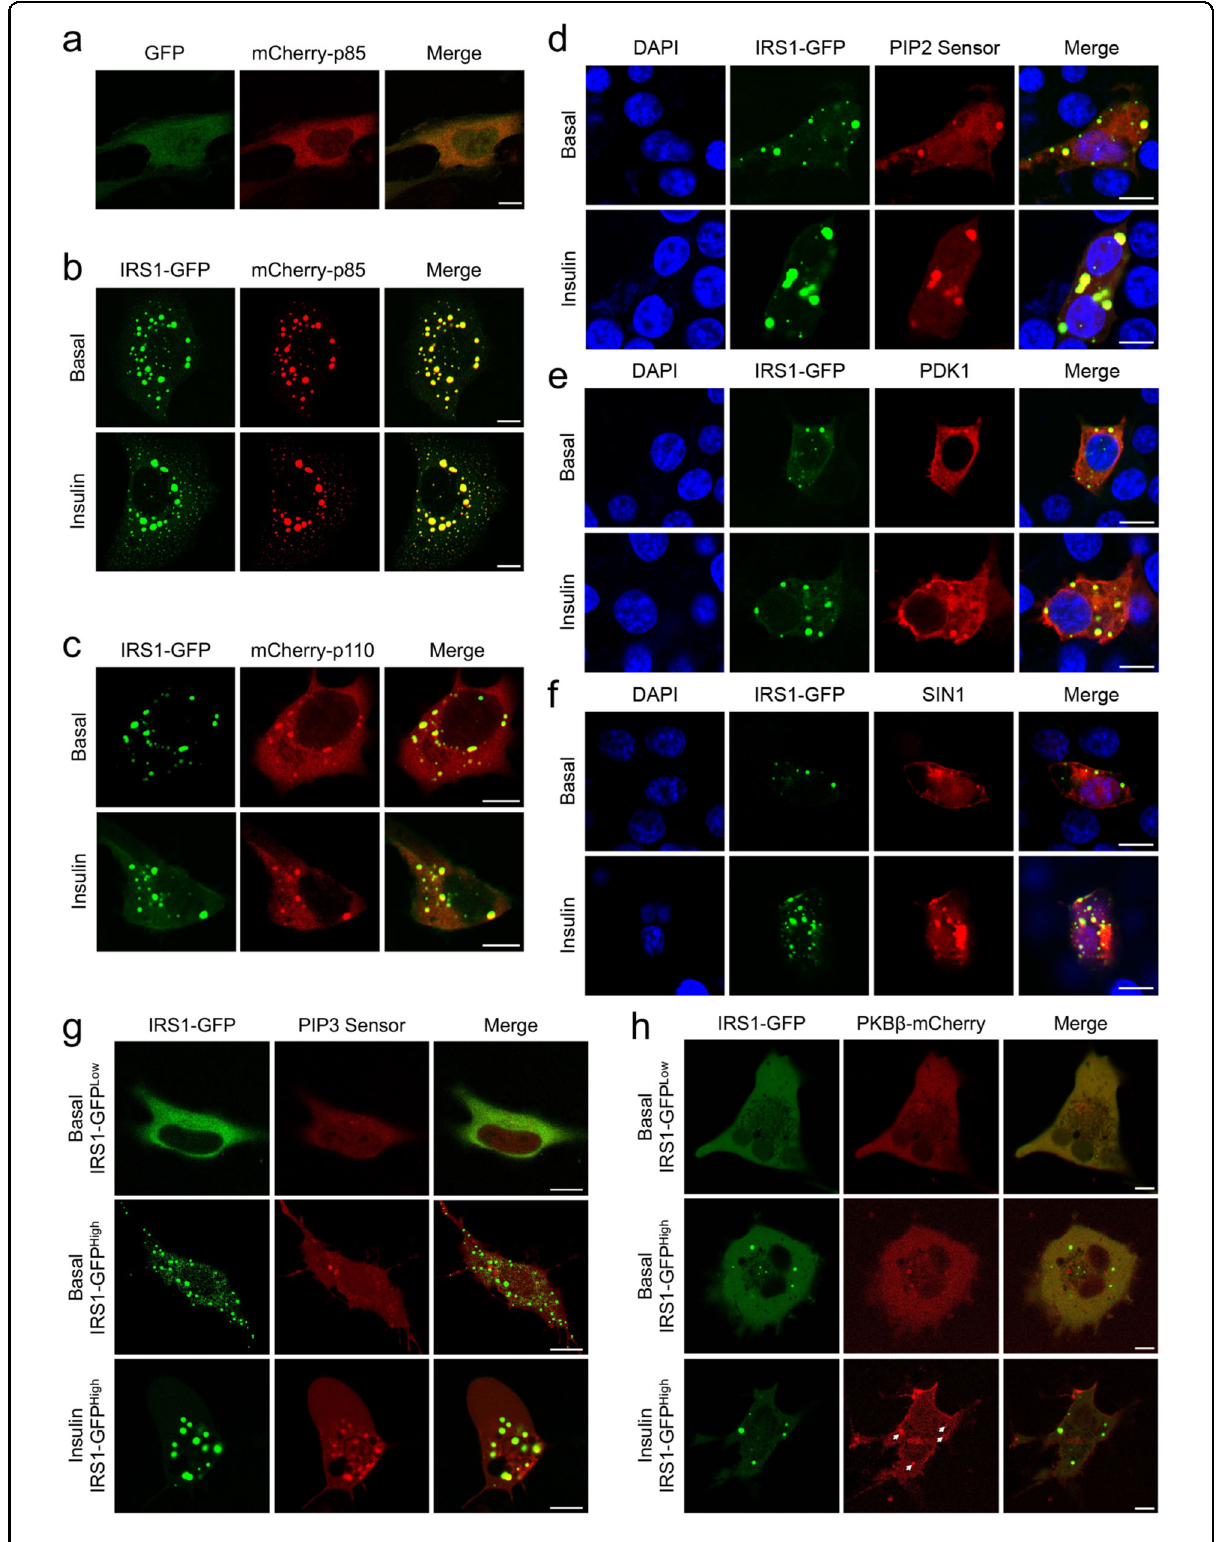
Fig. 5 (See legend on next